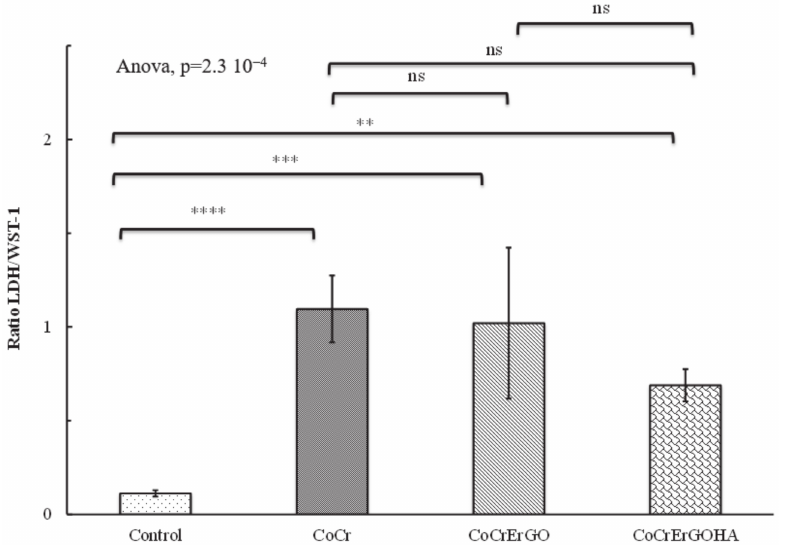
Figure 6. Effect of CoCr, CoCrErGO, and CoCrErGOHA surfaces in the LDH/WST-1 activity ratio as a measurement of macrophages’ J774A.1 citocompatibility. Macrophages were also cultured in the absence of any discs, used here as a control (Cells). Differences were significant at p value ≤ 0.05 (**: p ≤ 0.01, ***: p ≤ 0.001 and ****: p ≤ 0.0001) and values with p > 0.05 were considered non significant (ns).